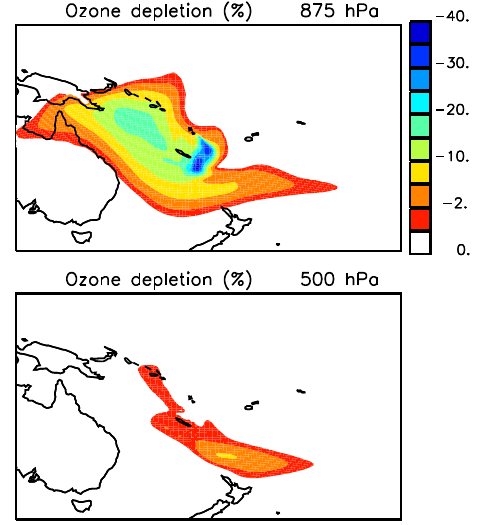
lated ozone in S1_HighT and in S0 (in % relative to S0) at 875 and 500hPa for the 50km × 50km